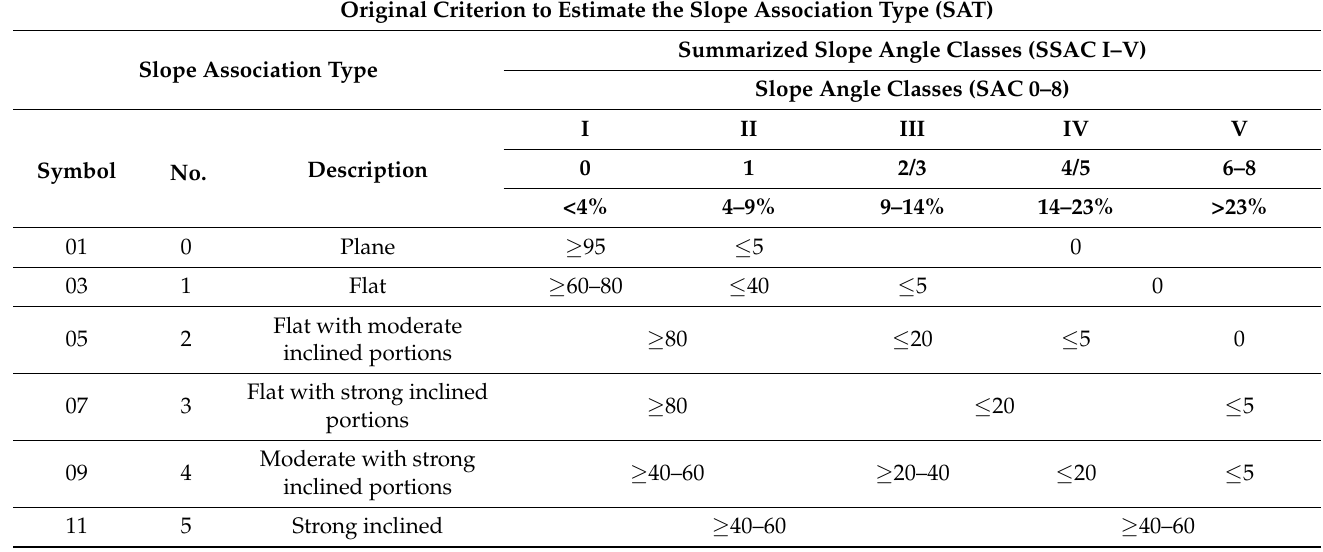
Table 1. Original slope association types of the medium-scale agricultural site mapping [17], p.